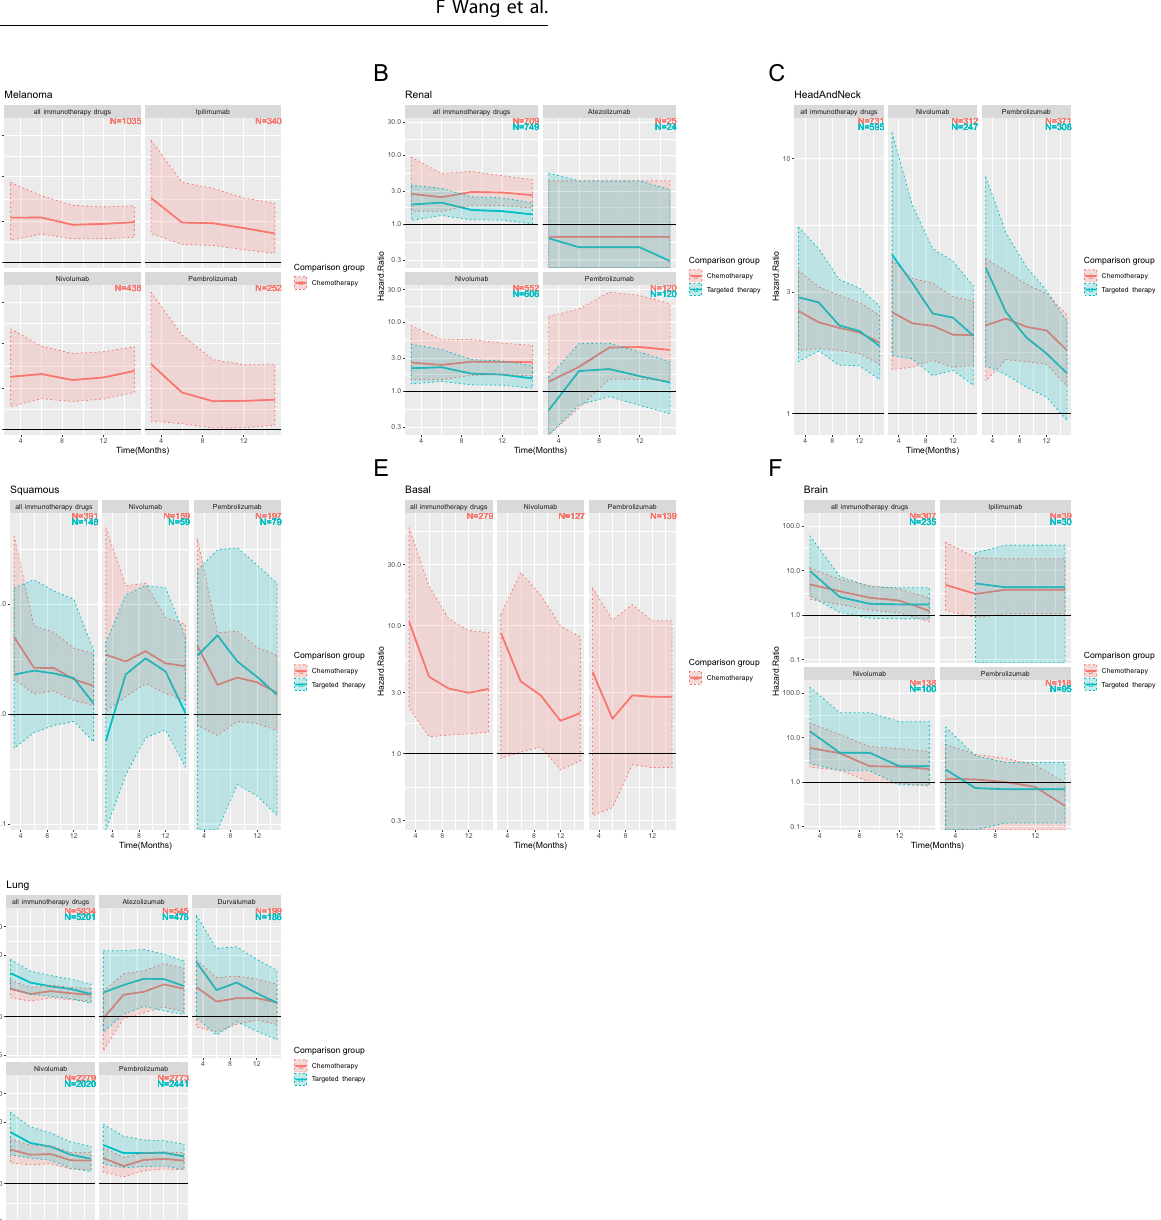
Fig. 2 The immunotherapy group has a higher risk of developing subsequent irAEs across all cancer types under study. A Melanoma. B Renal cancer. C Head and neck cancer. D Squamous cell carcinoma. E Basal cell carcinoma. F Brain cancer. G Lung cancer. The point estimates of the hazard ratios comparing the immunotherapy group with either chemotherapy (red curves) or targeted therapy (cyan curves) in 3, 6, 9, 12, and 15 months after treatment initiation are shown. Their corresponding 95% con fi dence intervals are displayed by the shaded areas. Chemotherapy agents include carboplatin, cisplatin, doxorubicin, fl uorouracil, gemcitabine, and paclitaxel. Targeted therapy agents include bevacizumab, temsirolimus, axitinib, cabozantinib, erlotinib, everolimus, pazopanib, sorafenib, and sunitinib. The detailed list of CPT/HCPCS procedure codes and national drug codes can be found in Tables S3 – S6. The number on the top right indicates the number of matched patients in the treatment group. With the exception of renal cancer, the hazard ratios did not differ signi fi cantly when using the chemotherapy group or the targeted therapy group as the comparison group. With the exception of comparing immunotherapy with targeted therapy among patients with squamous cell carcinoma of the skin and brain cancer, the 95% con fi dence intervals in all other comparisons involving all immunotherapy drugs do not include